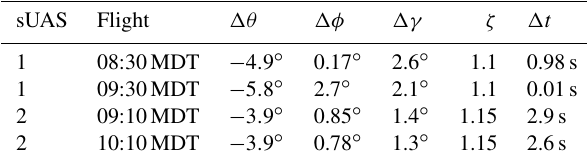
Table 1. Components of (cid:49)(cid:15) determined by optimization for each sUAS for both